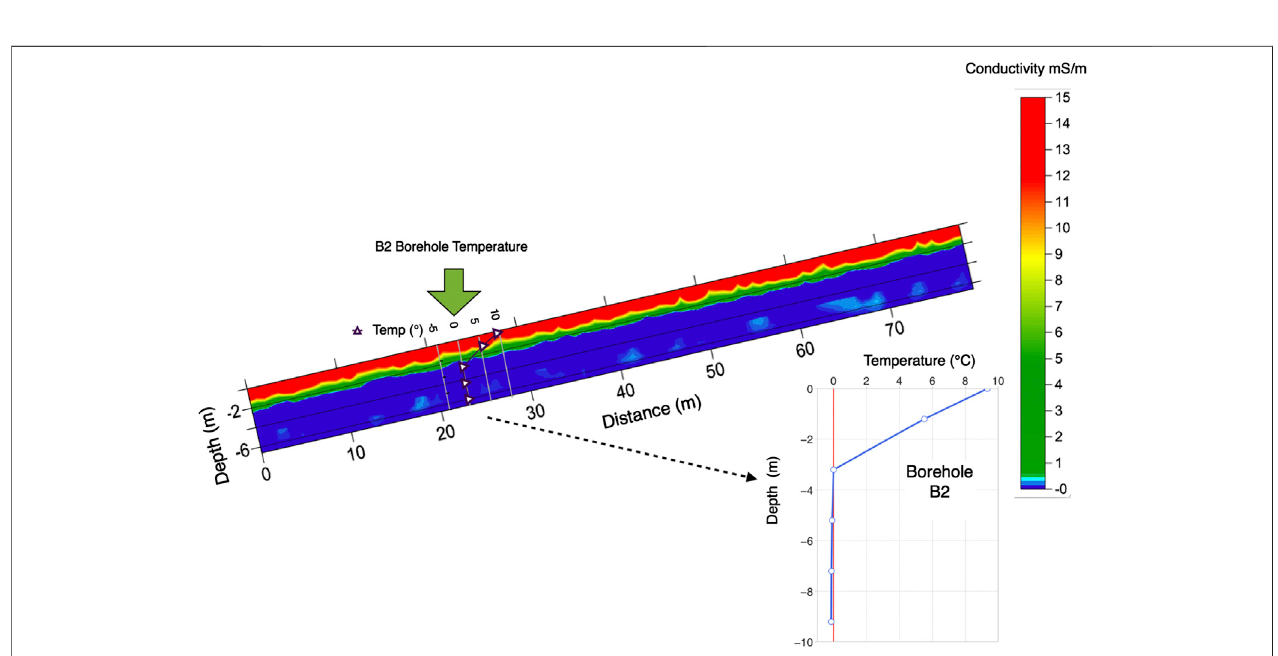
FIGURE 6 | Results of FDEM survey along the borehole B2 on July 30, 2019. The borehole B2 is shown, the lower panel shows the daily mean temperatures collected on the same day.